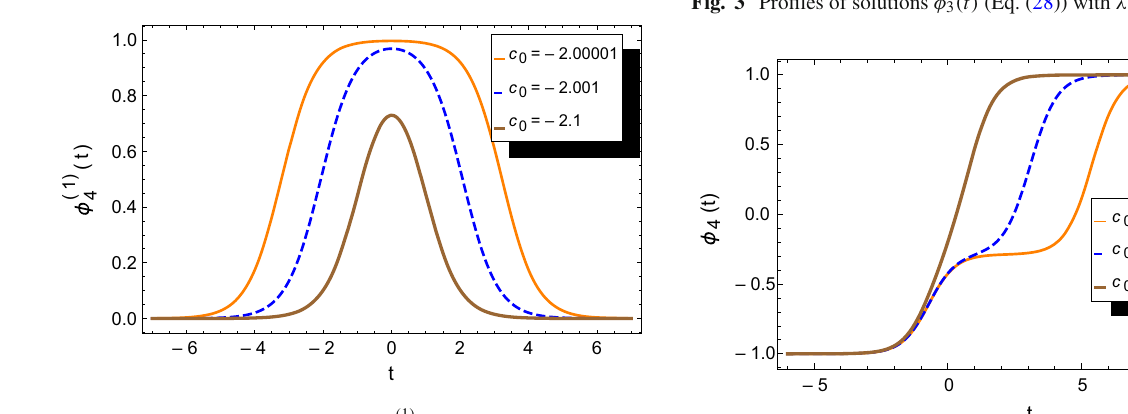
( t ) (Eq. (21)) with μ = 1 3